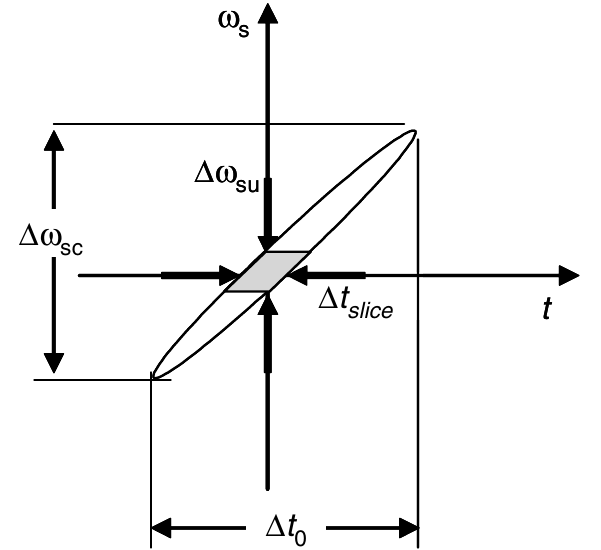
FIG. 11. Longitudinal phase space of a chirped x-ray